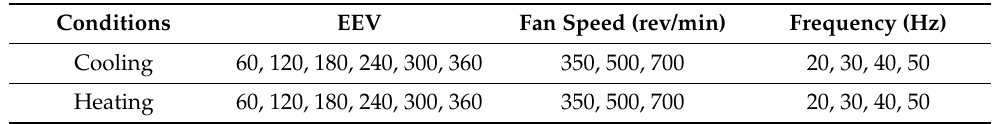
Table 2. Experiment variables in case 3.